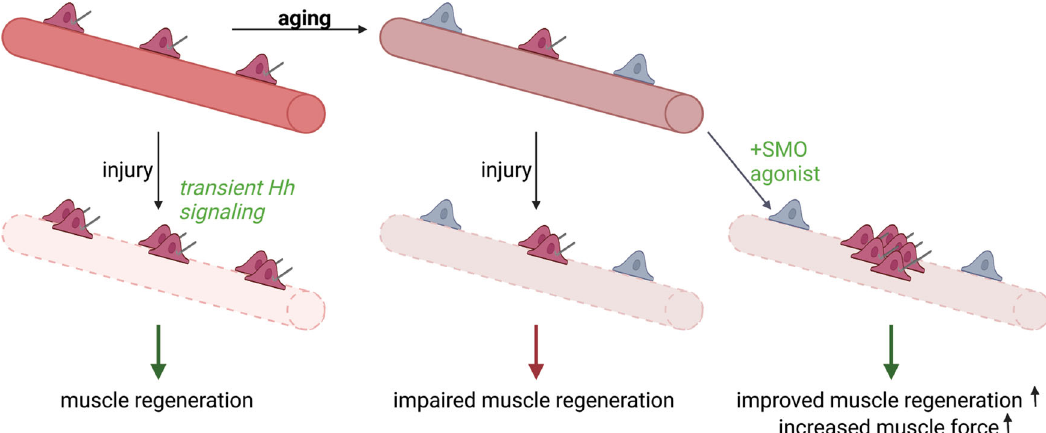
Fig. 6 Scheme of primary cilia function in muscle regeneration. Notexin-induced muscle injury induces transient Hedgehog signaling in MuSCs, which results in MuSC expansion, a critical step in muscle regeneration. The primary cilium is lost in a signi fi cant fraction of aged MuSCs, and exogenous activation of Hedgehog signaling increases muscle force in aged. Created with